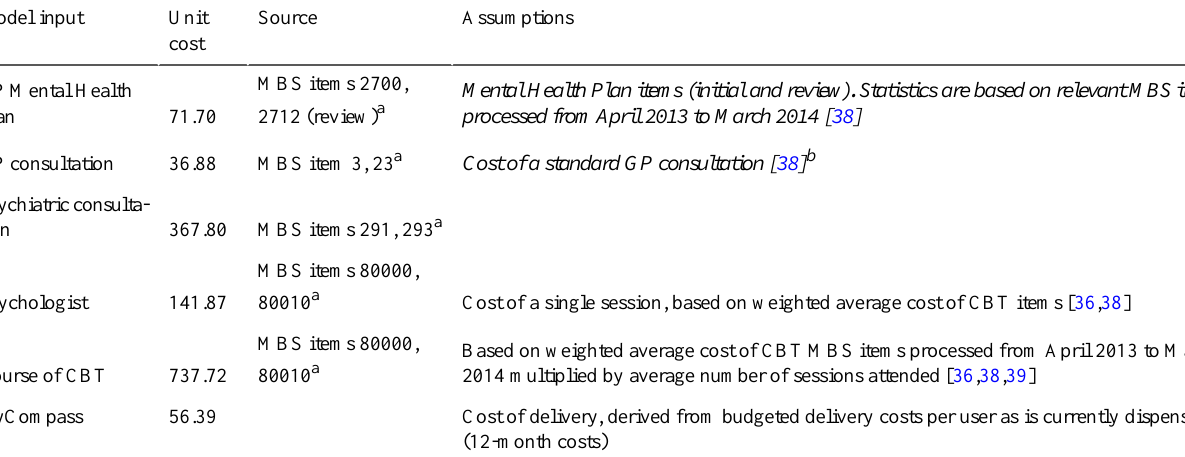
Table 2. Resource unit